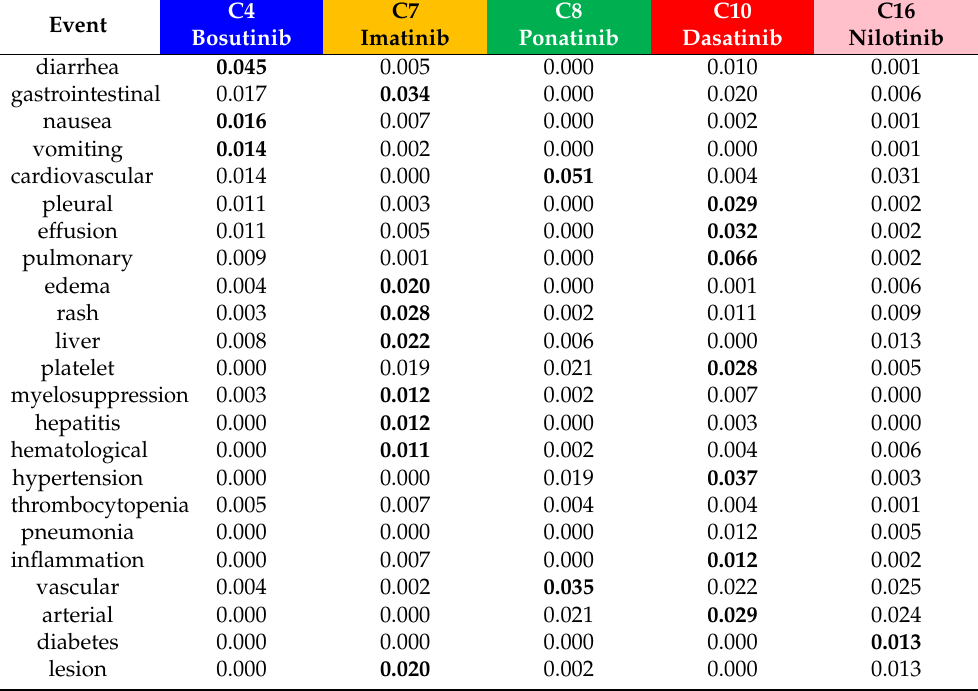
Figure 5. Mapping specific TKIs to AEs. The color of each bar corresponds to the color of the cluster in the previous scatter plot (Figure 4). The frequency of occurrence of each TKI in its related cluster is printed next to each bar. A chi-squared test with Bonferroni correction found a significant difference in fold change. Fold change refers to the difference in frequency of a term within a cluster when compared to its frequency within the corpus as a whole. Color of the asterisk(s) illustrates a significant difference between the cluster depicted in the bar and the cluster depicted by the color of the asterisk. Significance is denoted by family-wise alpha of 0.05. Table 1. Color coding corresponds to colors of clusters in the cluster plot (Figure 4). The terms and clustering frequency illustrate the frequency of different adverse events across each cluster. Maximum frequency across all clusters is indicated with boldfaced